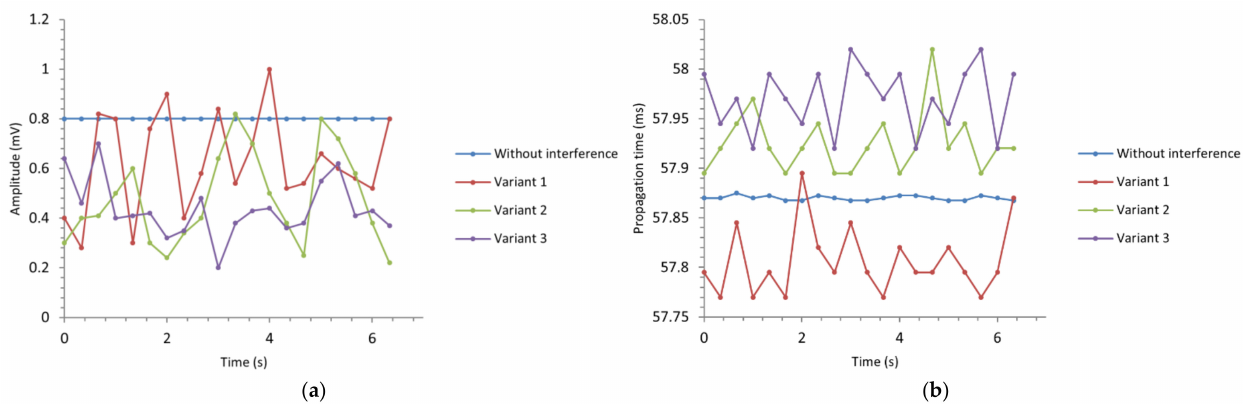
Figure 15. ( a ) Voltage amplitudes recorded in the receiver system, with different variants of the sources of interference arrangement (AR41); ( b ) Ultrasonic wave propagation time, at distance 20 m